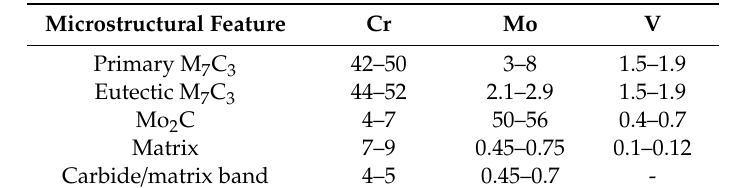
Figure 2. Initial Cr12 roller steel microstructure: ( a ) backscatter secondary electron (BSE) micrograph; ( b ) elemental distribution of Mo. Table 2. Approximate range of elemental content for primary and eutectic carbides, matrix and carbide/matrix band in wt. %.